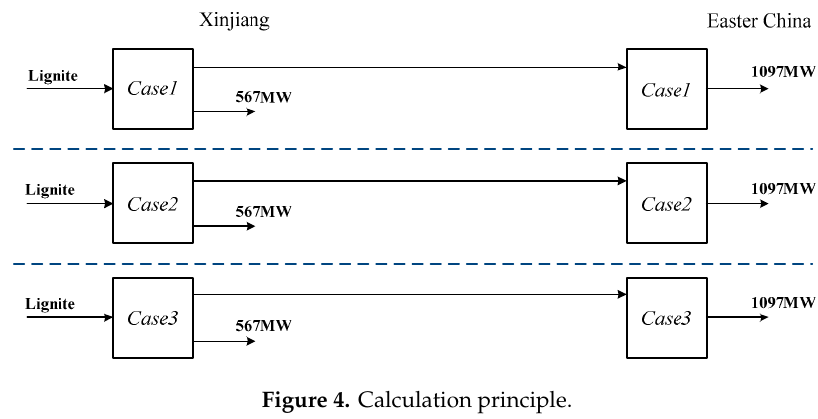
Figure 4. Calculation principle.